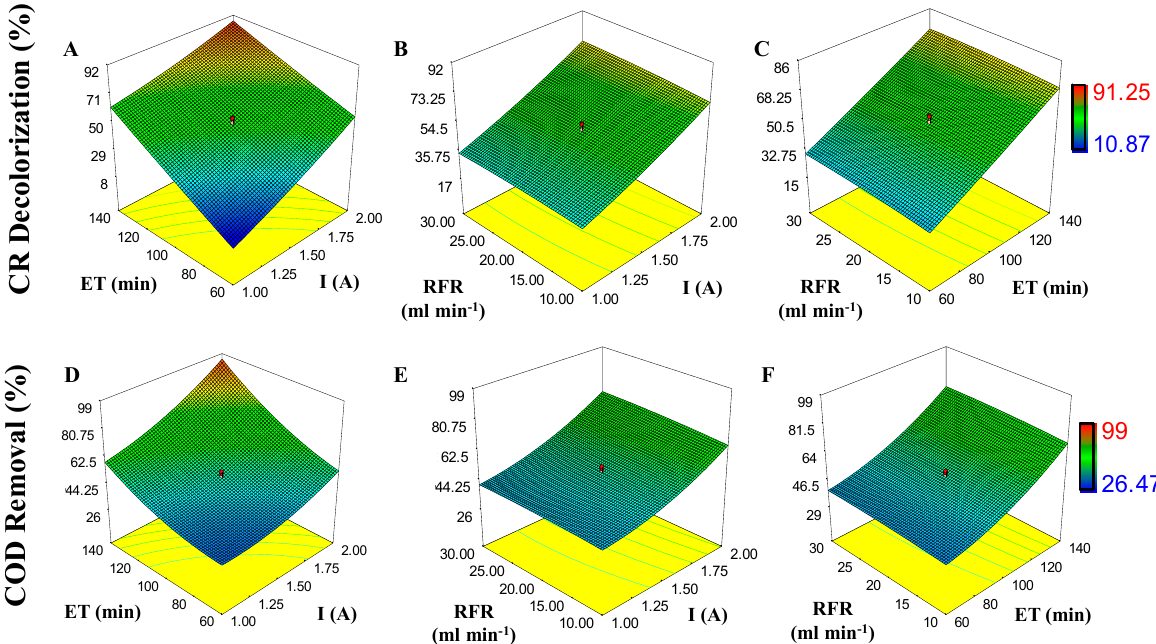
Figure 3. Effect of independent variables (I, X1; RFR, X2, and ET, X3) on response variables (CR decolorization and COD removal) during electrooxidation process (EO): ( A ) ET and I on CR decolorization; ( B ) RFR and I on CR decolorization; ( C ) ET and RFR on CR decolorization; ( D ) ET and I on COD removal; ( E ) RFR and I on COD removal; ( F ) RFR and ET on COD removal. Table 3. ANOVA results for the response surface quadratic model for CR decolorization and COD removal in EO and EC processes. Source